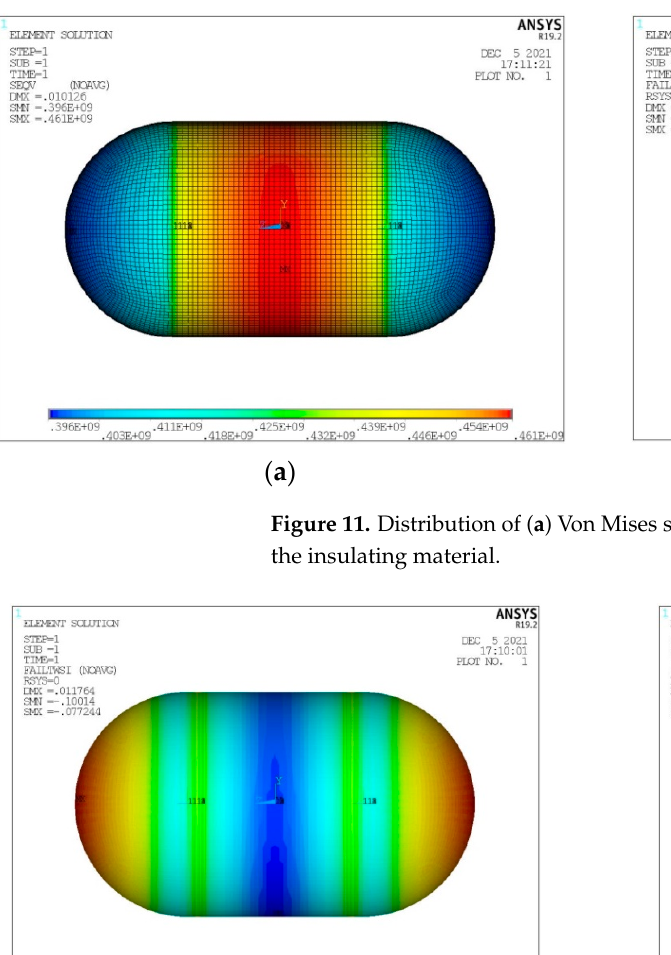
Figure 10. Heat flux distribution for ( a ) inner aluminum shell, ( b ) insulating material, ( c ) outer composite shell.